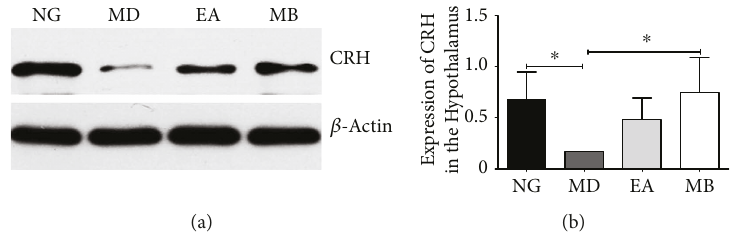
Figure 9: The expressions of CRH in the hypothalamus. (a) Western blot analysis of CRH in the hypothalamus. (b) Quanti fi cation of (a) ( n = 6 /group). The results showed that the hypothalamic CRH expression in the MD group was signi fi cantly reduced (vs. NG group, ∗ P < 0 05 ), but that in both the EA and the MB groups was enhanced (vs. MD group), and there was obvious di ff erence between MD and MB group ( ∗ P < 0 05 ). CRH: corticotropin-releasing hormone. NG: normal group; MD: model group; EA: electroacupuncture group; MB: moxibustion